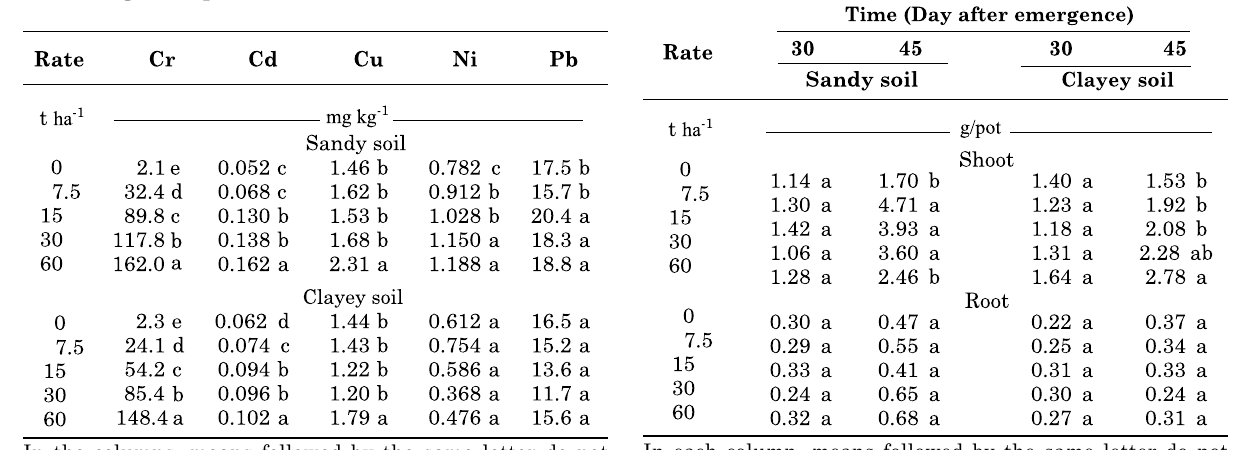
Table 3. Heavy metals contents in the sandy and clayey soils after amendment with tannery sludge compost